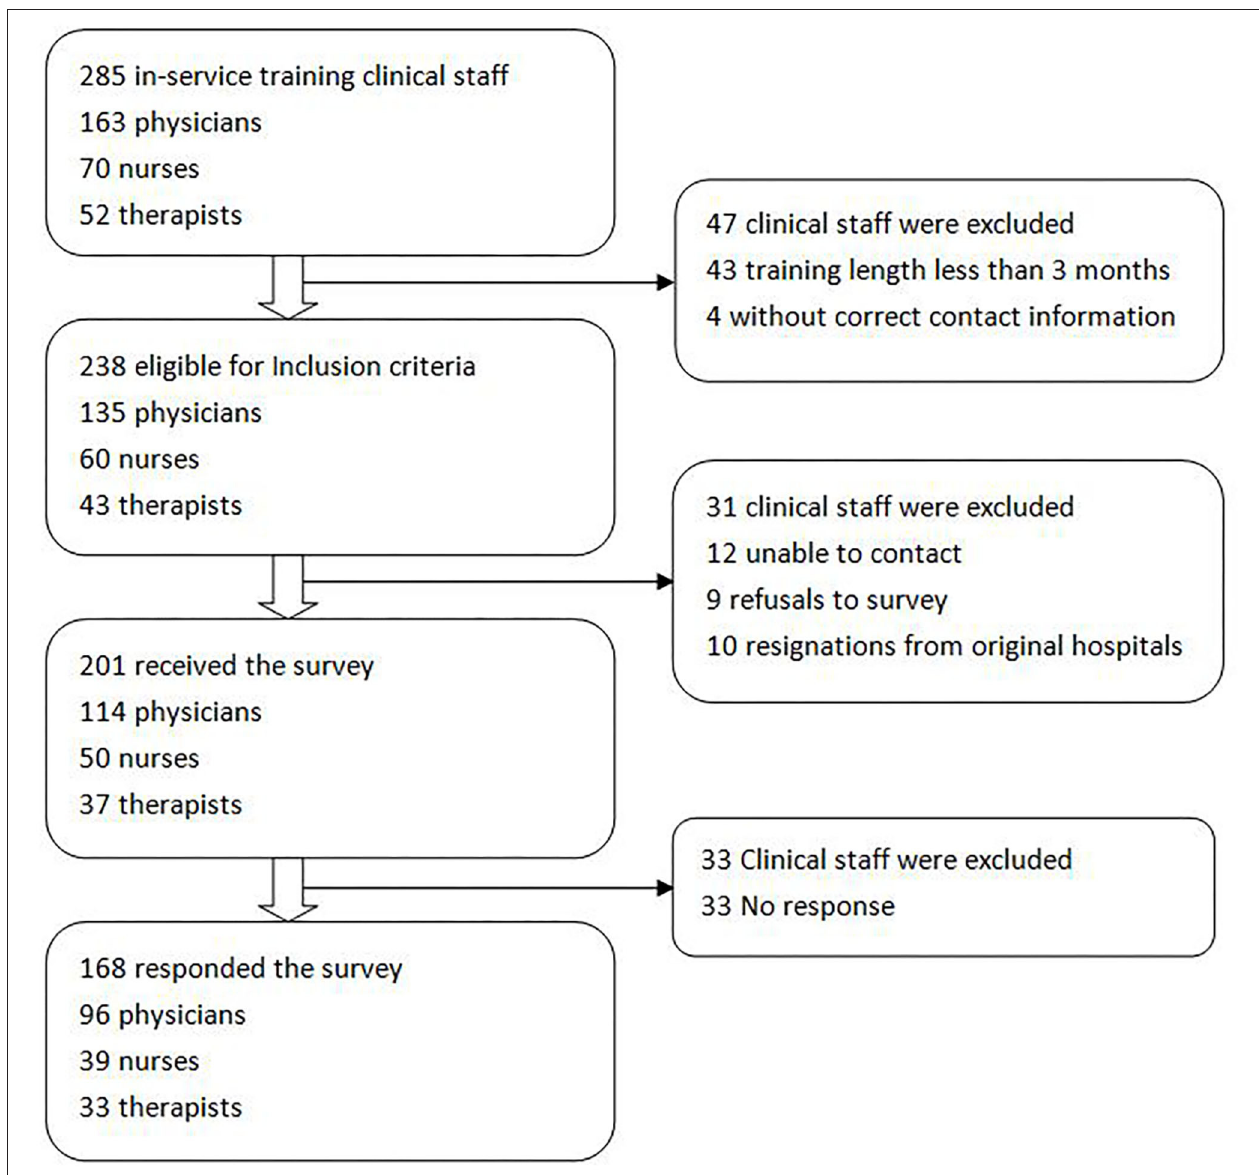
FIGURE 2 | Flow chart of the